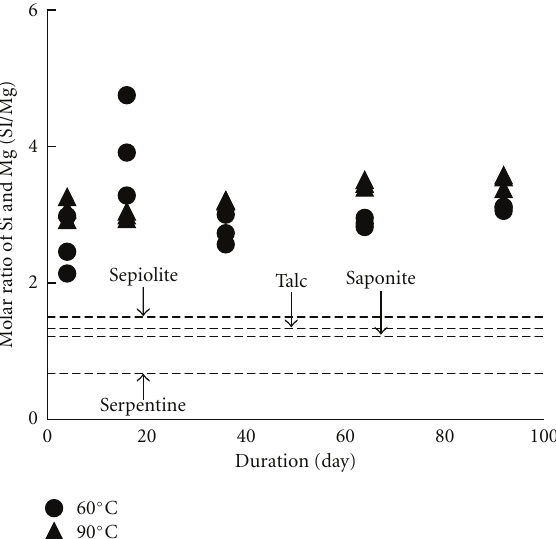
Figure 6: Calculated molar ratio of Si to Mg in the altered layers versus time for the tests in MgCl 2 solution at 60 ◦ C and at 90 ◦ C. The dashed lines indicate the Si/Mg molar ratios of typical magnesium silicate.